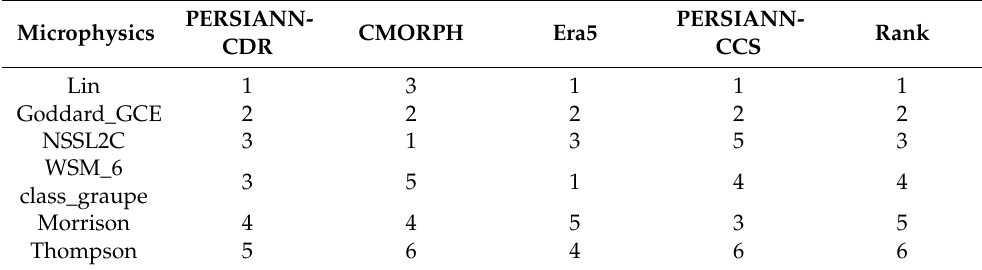
Table 7. Performance order of different microphysics schemes based on Mode analysis.